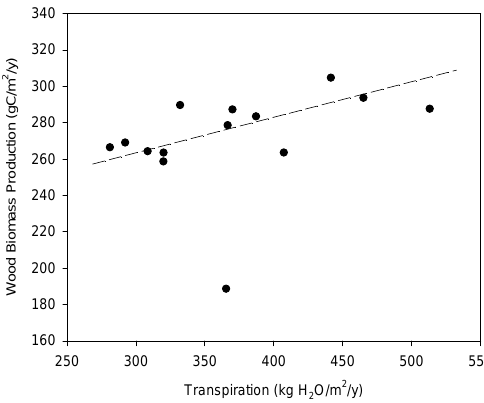
Fig. 5. The relationship between estimated T and Wood Biomass Production (WBP) in the Gwangneung catchment from 1991 to